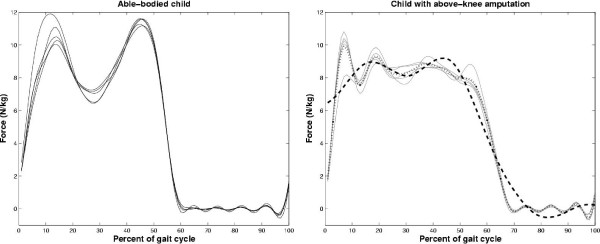
Inconsistency in multiplicity and location of local extrema. Graphs portray registered vertical ground reaction force curves from an able-bodied child (left) and from a child with above-knee prosthesis (right). The dotted line on the right is the mean curve while dashed line is the wavelet reconstructed mean curve.